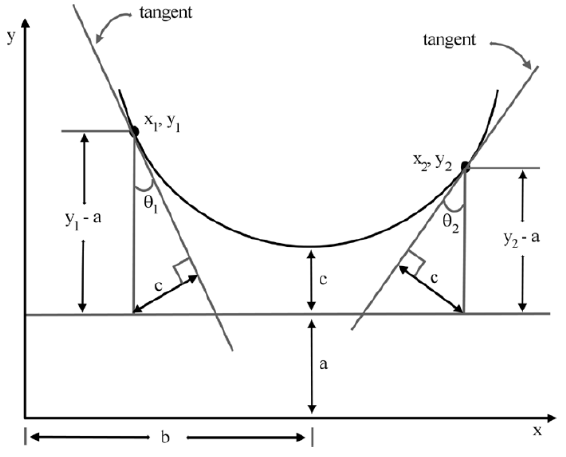
Figure 9. Computing catenary parameters( a , b , c )